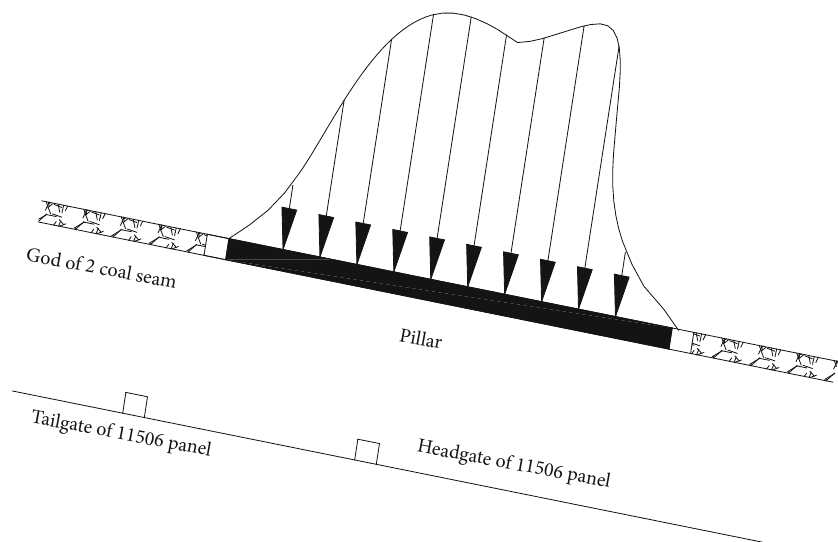
Figure 5: Roadway position relationship and stress fi eld superposition.